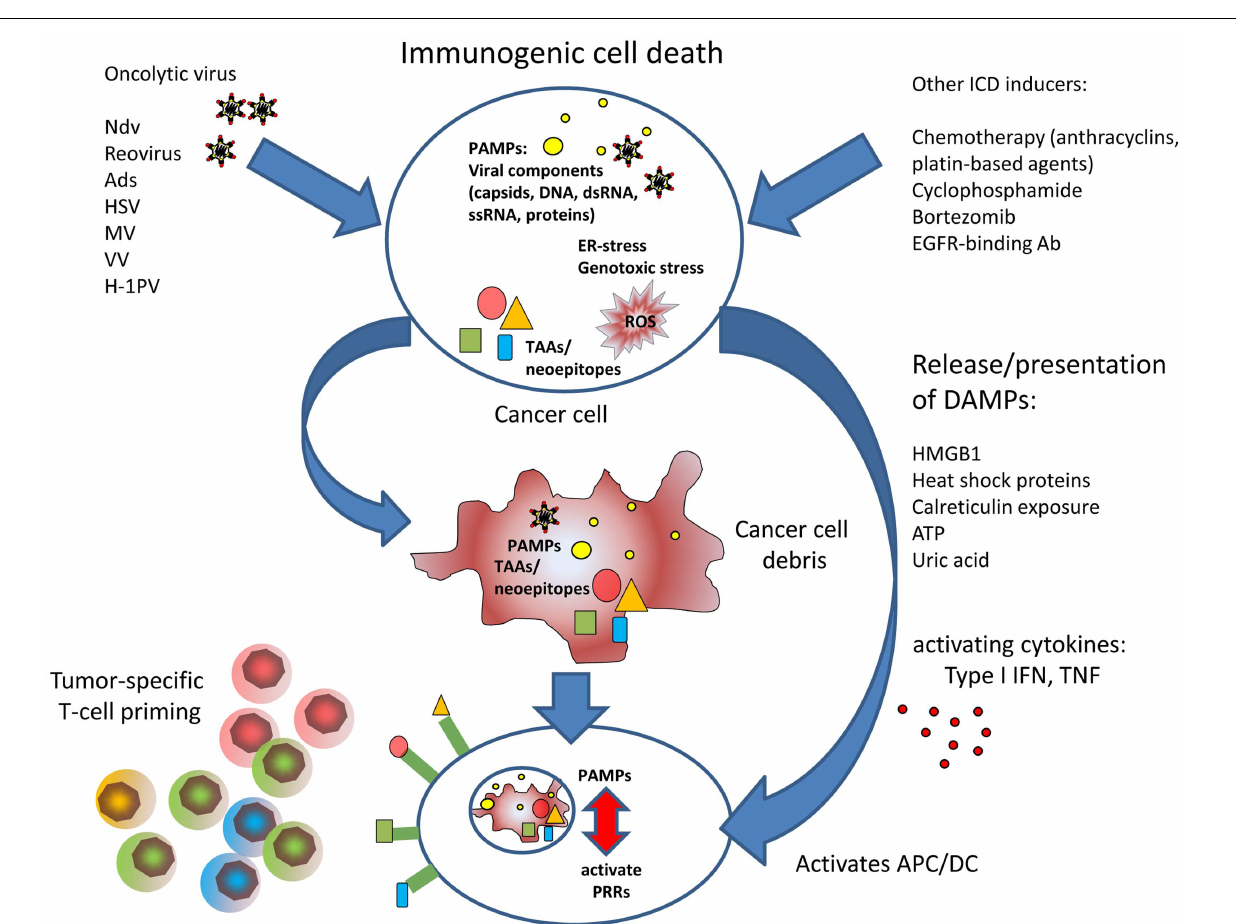
FIGURE 1 |The figure illustrates the improvedT cell priming in oncolytic virotherapy .Viral oncolysis of tumor cell induces immunogenic cell death by accumulation of PAMPs and accompanied by release of DAMPs. PAMPs and